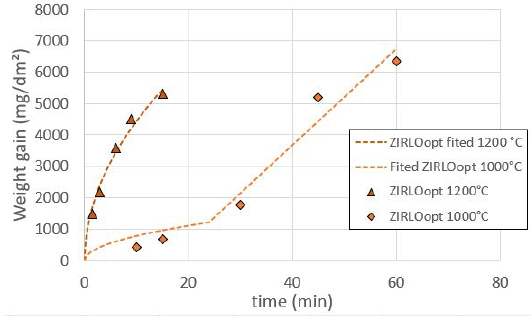
Figure 4. Weight gains for uncoated Optimized ZIRLO™ tested in air at 1000 and 1200 °C. Pre- and post-breakaway regions are visible for 1000 °C but at there’s not breakaway at 1200 °C since the kinetics is accelerated from the beginning.